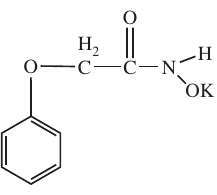
H OCH CONHOK = 6 5 2